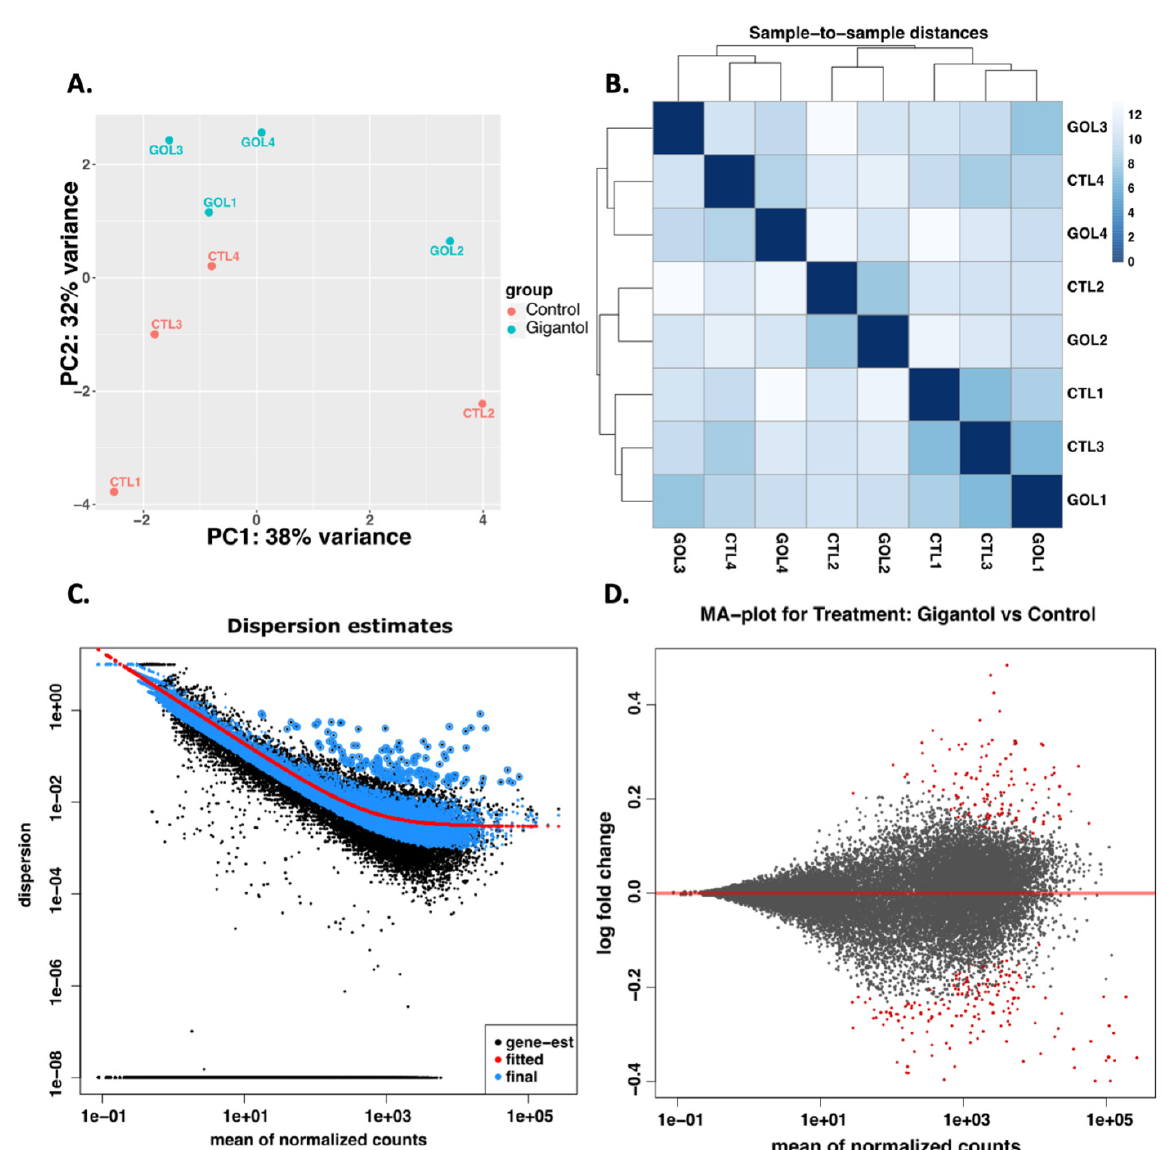
Figure 2. Overview of RNA-Seq data from MA-10 Leydig cells treated with gigantol 10 μ M for 4 h. ( A ) The principal component analysis results showing that samples from gigantol treatment are clustered compared to non-treated samples. ( B ) Sample-to-sample distance heatmap performed on transcripts identified in non-treated and gigantol-treated MA-10 Leydig cells from four independent biological replicates. ( C ) The dispersion estimate plot shows the gene-wise estimates (black), the fitted values (red), and the final maximum a posteriori estimates used in testing (blue), where the black points circled in blue are detected as dispersion outliers. ( D ) The MA plot of RNA-Seq data compares gigantol treated to control samples. The x -axis shows mean expression for each gene, and the y -axis shows log2 fold change (gigantol treated versus control), as estimated in DESeq2.